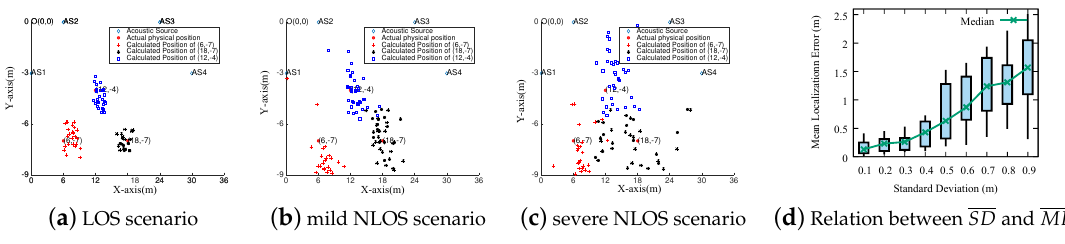
Figure 3. Experimental